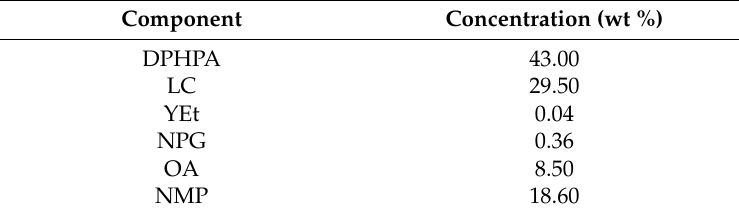
Composition of the holographic photopolymer. DPHPA: dipentaerythritol penta/hexa-acrylate; LC: liquid crystal; YEt: ethyl eosin; NPG: N -phenyl glycine; OA: octanoic acid; NMP: N -methyl-2-pyrrolidone. Component Concentration (wt